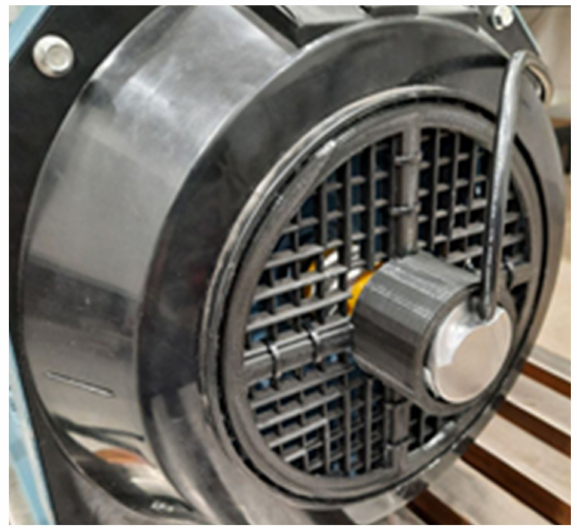
Figure 4. The 3D printed holder and coupling for mounting the encoder on the